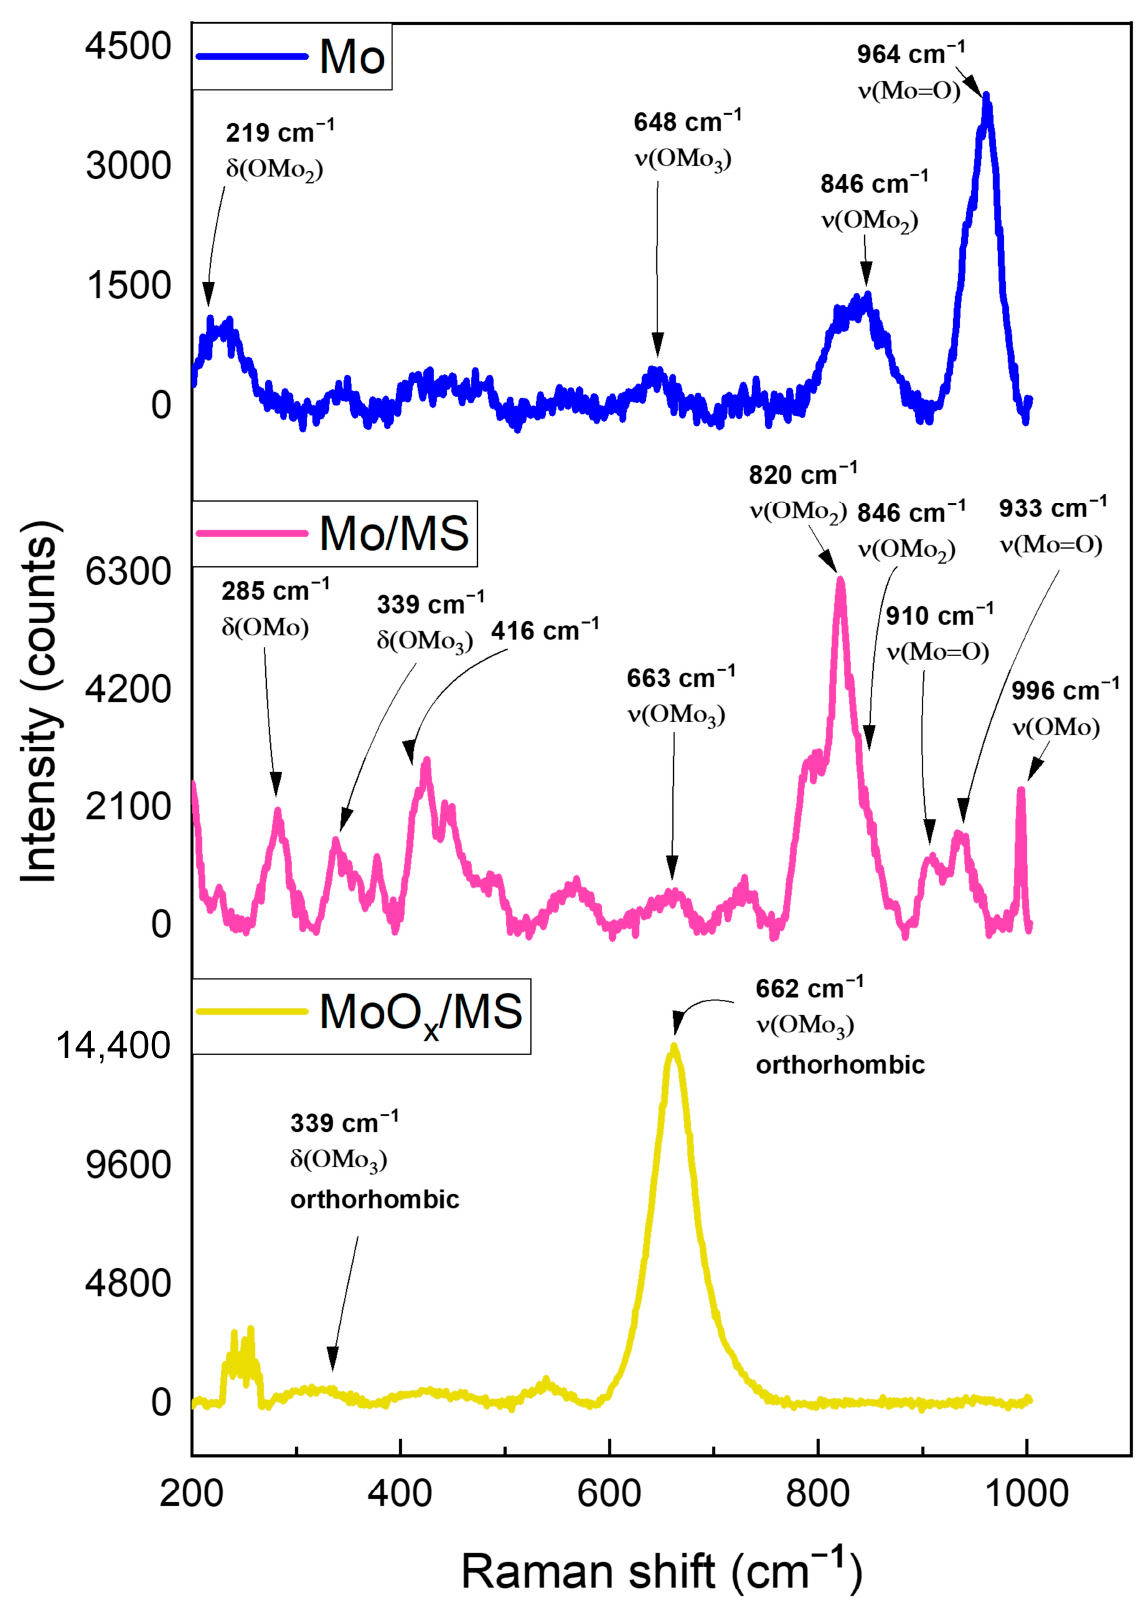
Figure 7. Raman spectra of the molybdenum source (Mo), as-deposited molybdenum (Mo/MS), and fully treated molybdenum to obtain molybdenum oxide (MoO x